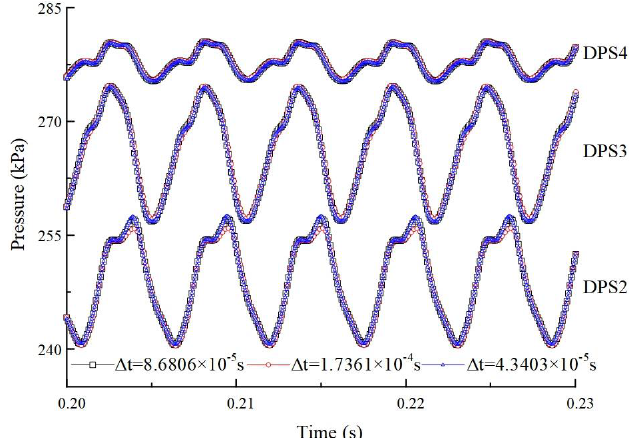
Figure 4. Independence test of time steps.